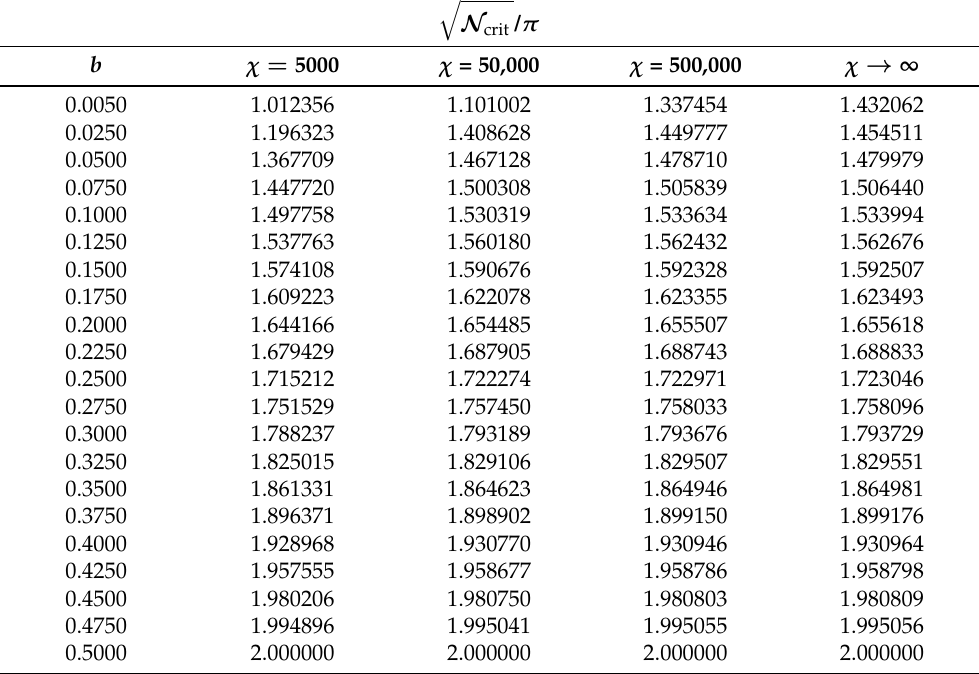
Table 9. The critical forces of PssP beams if χ = 5000, . . ., 500,000 and χ → ∞ .